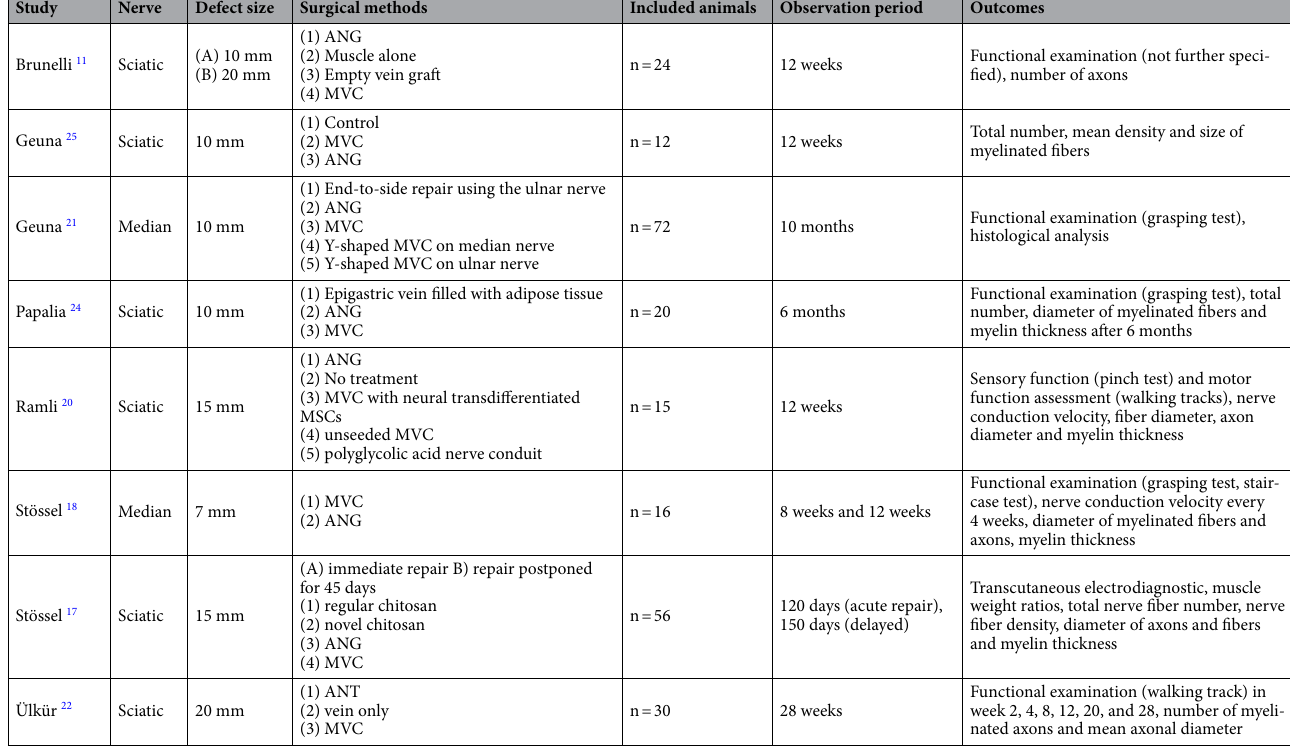
Table 2. Extracted details of the included preclinical studies.